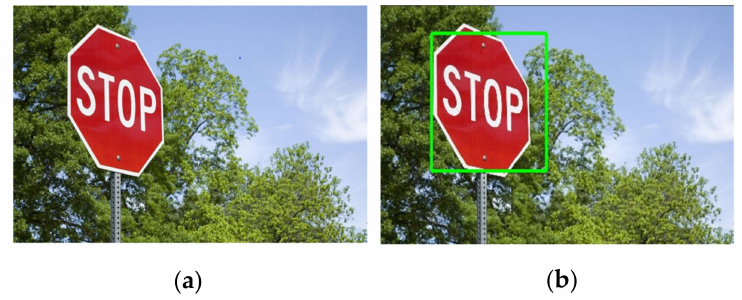
Figure 10. ( a ) Original image; ( b ) Detected